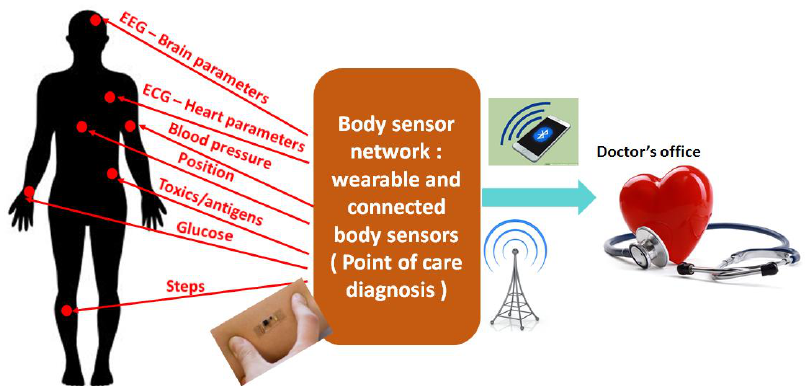
Figure 1. Point of care testing (POCT) system. Inspection of vital body parameters can be performed at the patient site and the data can be transmitted using connected devices.